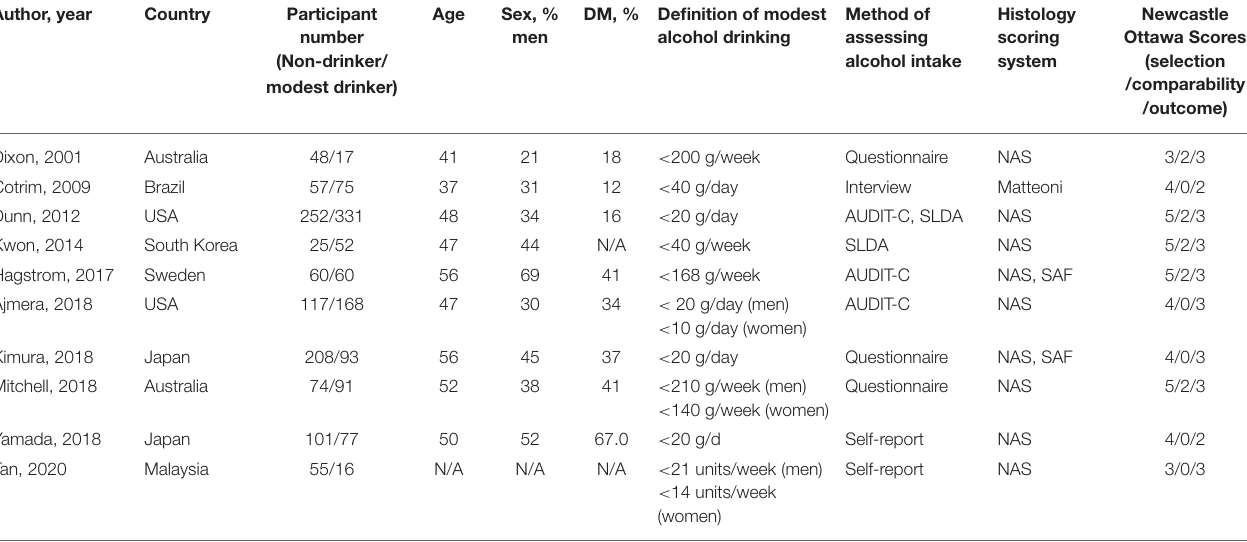
TABLE 1A | Characteristics of cross-sectional studies assessing histological severity between non-drinkers and modest drinkers included in the review. Author, year